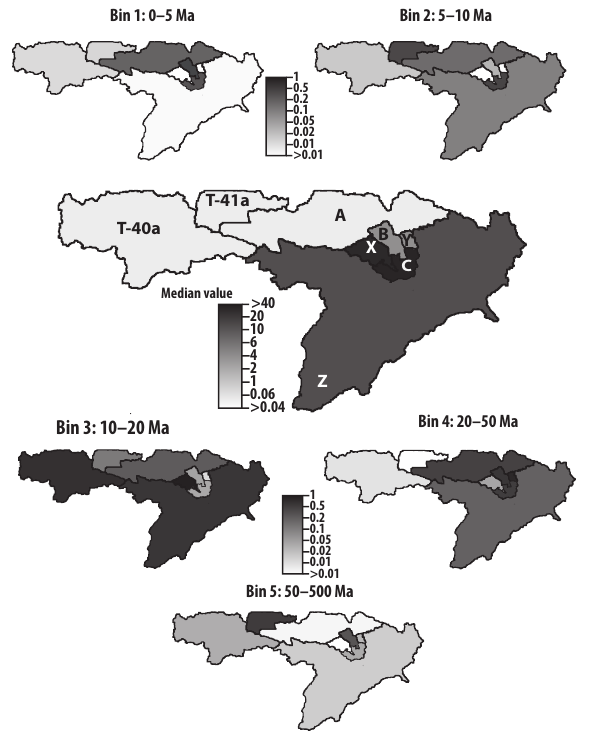
Figure 9. Maps of predicted median erosion rates (central panel) and relative surface age concentrations from the muscovite detrital data from eastern Himalaya. See Figs. 8 for full distributions and data.